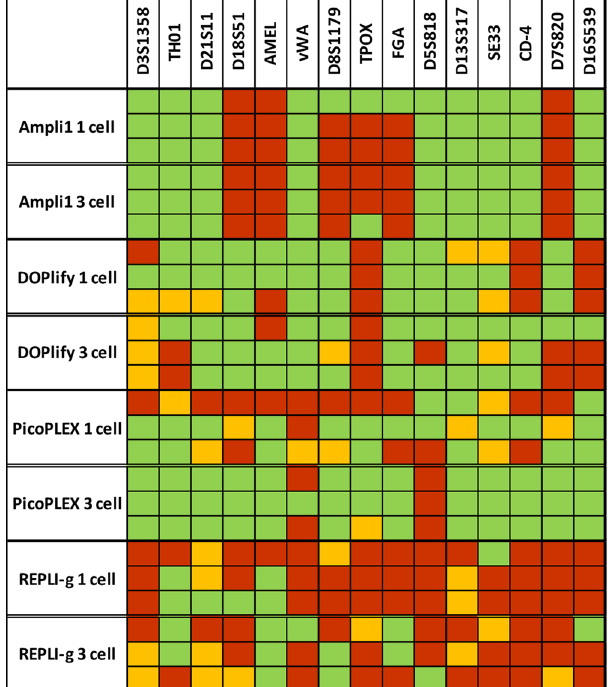
Figure 2. Overview of dropouts in STR profile for each WGA method. This figure illustrates which loci were called in the 1- and 3-cell samples for each WGA method. Correctly called loci are indicated in green. The orange squares represent allele dropouts, whereas a complete locus dropout is illustrated in